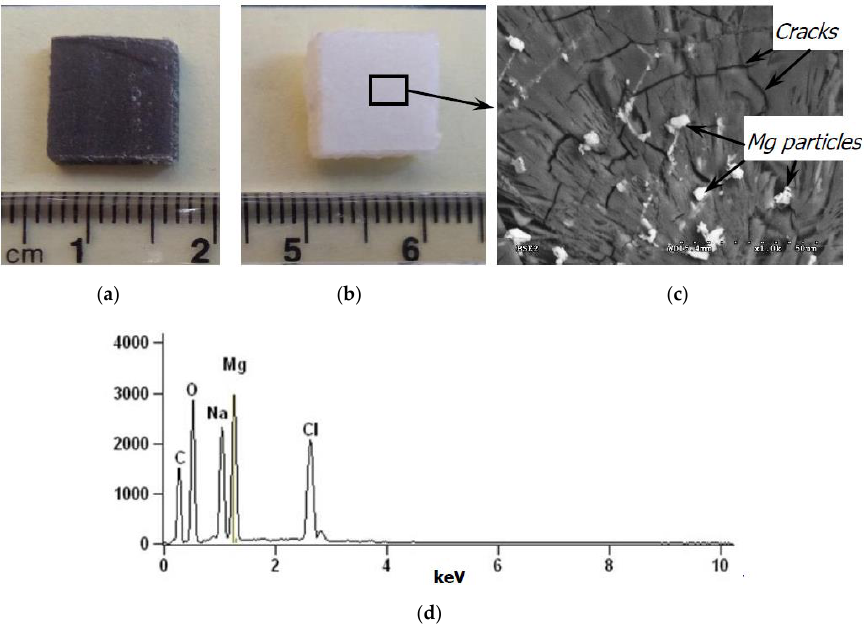
Figure 6. Elution of magnesium from the PLA-5%Mg composite ( a ) as-received, ( b ) after 120 days of testing, ( c ) SEM image of the PLA-5%Mg sample after 120 days of immersion (mag. × 1000), ( d ) SEM-EDS analysis of the Mg particles presented in Figure 6c (mag. ×